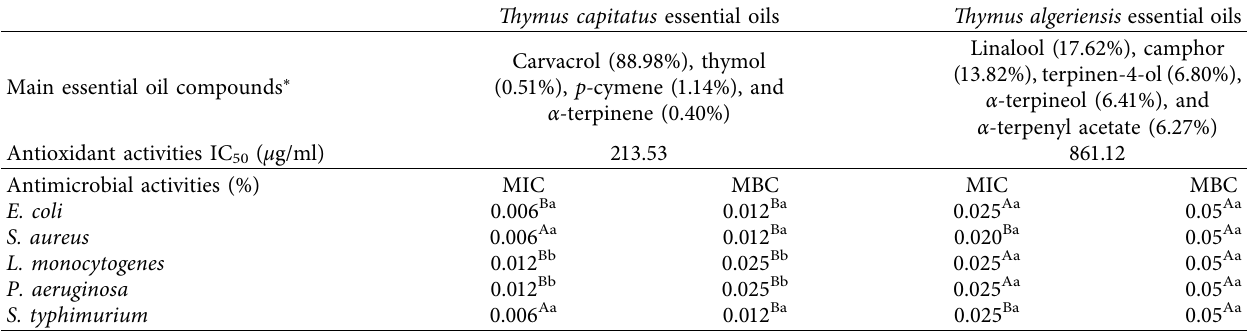
Table 1: Antioxidant and antimicrobial activities of Thymus capitatus and Thymus algeriensis essential oils. Thymus capitatus essential